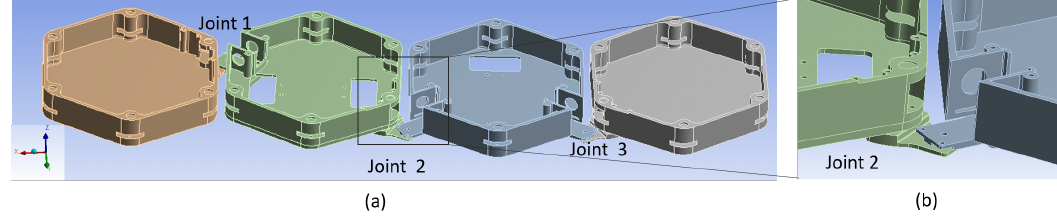
Figure 6. ( a ) CAD model of the hHoneycomb platform. ( b ) The enlarged view of the joint